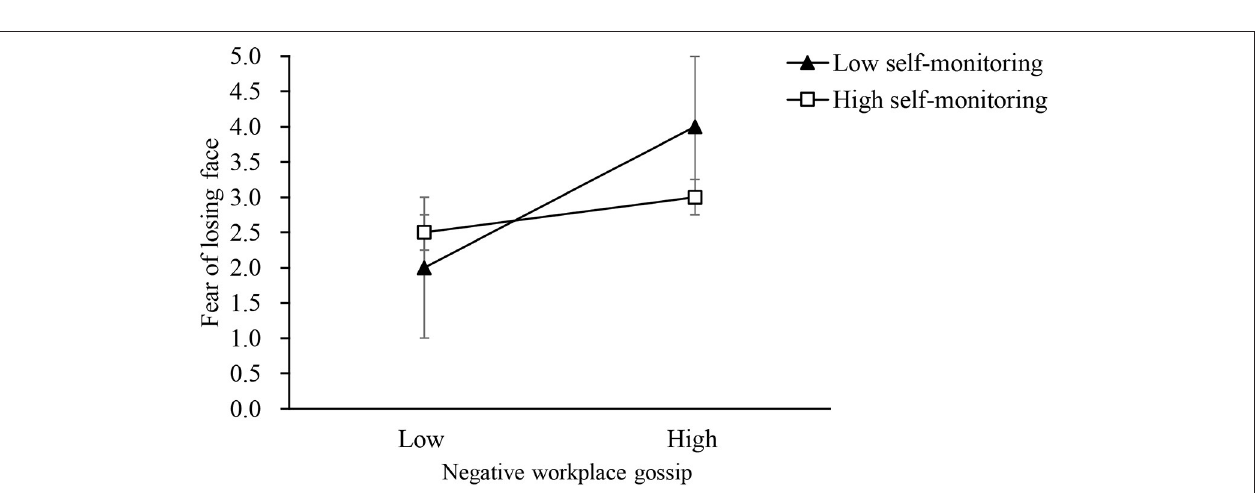
FIGURE 2 | The moderating role of self-monitoring on the relationship between negative workplace gossip and fear of losing face. Note: High and low levels represent 1 SD above and below the mean, respectively. The error bars are represented around the